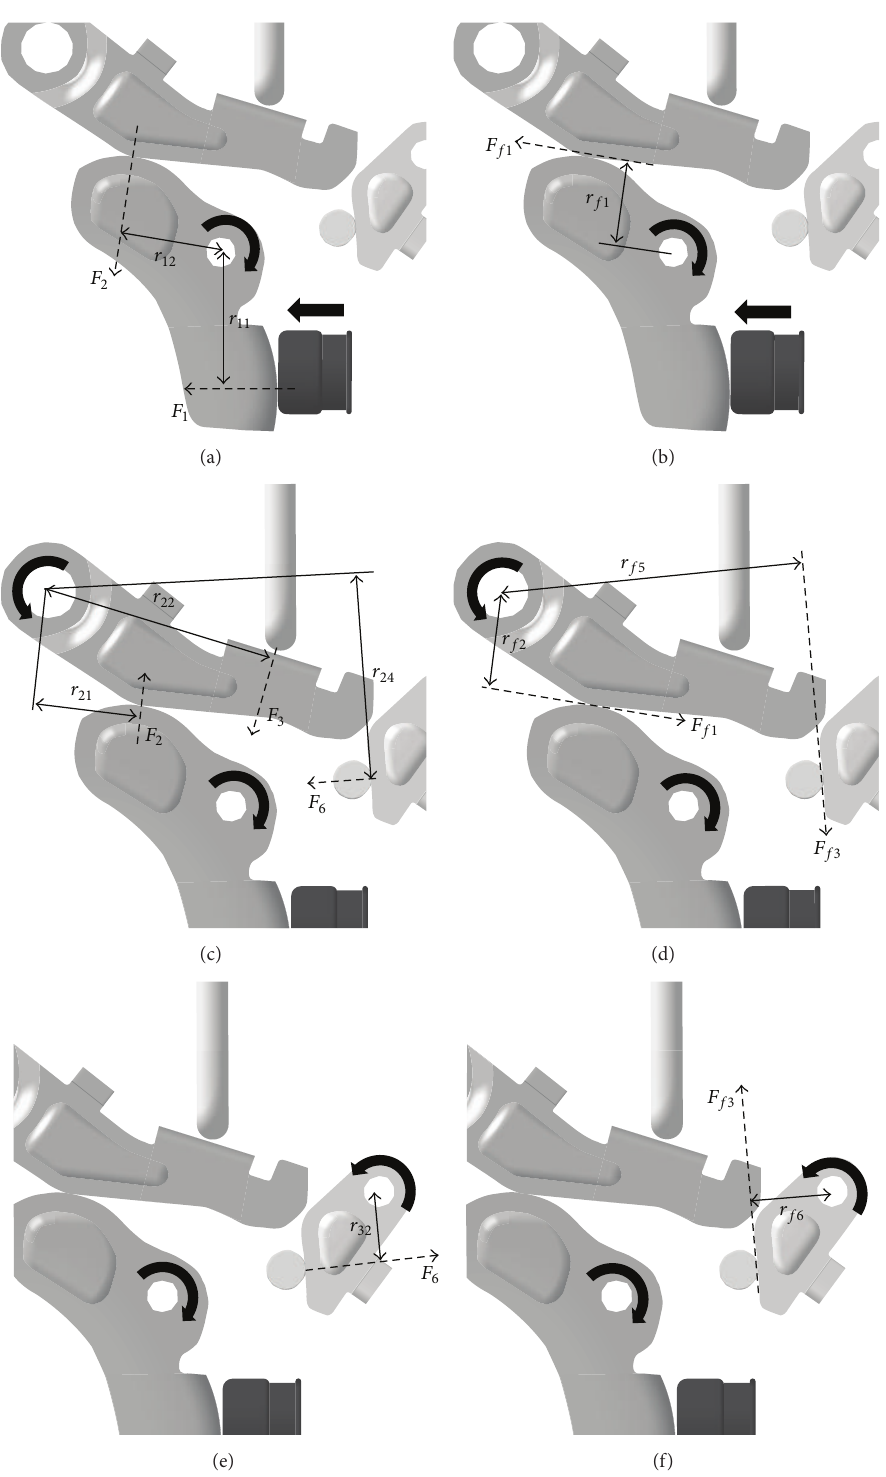
Figure 10: Free body diagram for solving moment at step 3: (a) free body diagram showing forces of bracket release, (b) free body diagram showing friction force of bracket release, (c) free body diagram showing forces of pop-up guide, (d) free body diagram showing friction forces of pop-up guide, (e) free body diagram showing force of emergency pawl, and (f) free body diagram showing friction force of emergency